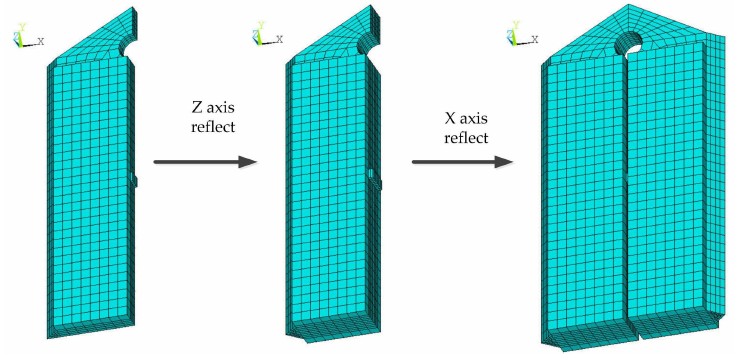
Figure 8. The finite element modeling process.